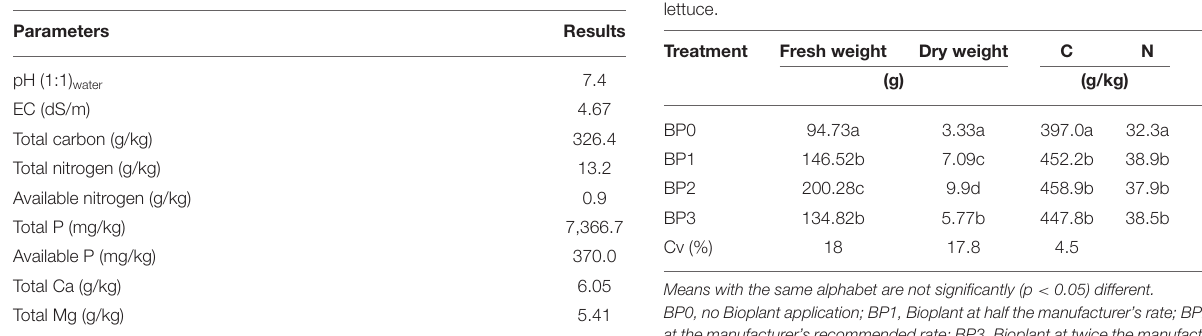
TABLE 2 | Some chemical properties of the compost used.